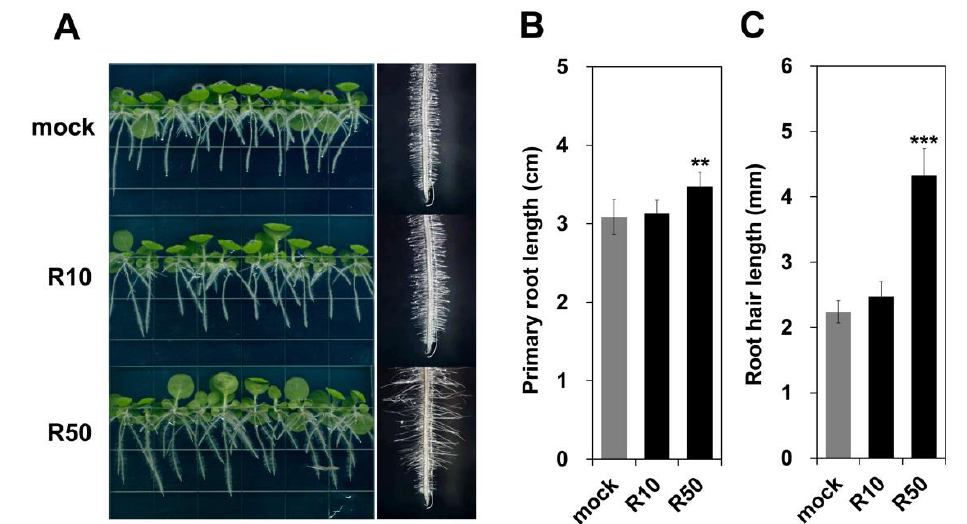
Figure 8. Root growth-promoting effects of rutin on tobacco seedlings. A . 16-day-old wild-type seedlings grown vertically on MS medium (without sucrose) containing 10 µM (R10), 50 µM (R50) rutin, or DMSO (mock) were compared (left column). The root hair was observed by microscopic examination (right column). B , Average primary root length of 30 seedlings. C , Average root hair length of at least eight primary roots. Data are expressed as mean ± SD, as determined from the replicates. Significant differences were determined by Student’s t -test. Asterisks indicate that the value is significantly different from that of mock treatment (** p < 0.01, *** p < 0.001).